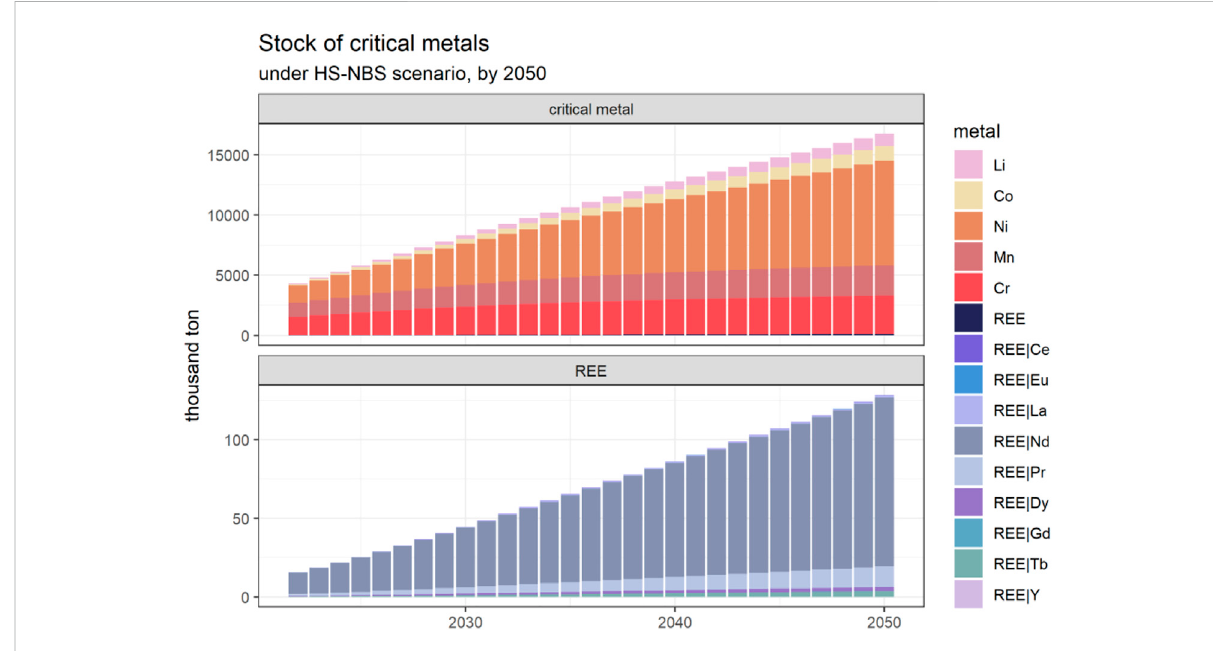
FIGURE 6 Stock of critical metals under HS-NBS scenario from 2022 to 2050 in China (thousand tons): total metal stock and the details in REE. Under the HS-NBS scenario, the stock of each critical metal continues to increase. Since the total REE stock is small, each REE metal details will be shown separately.